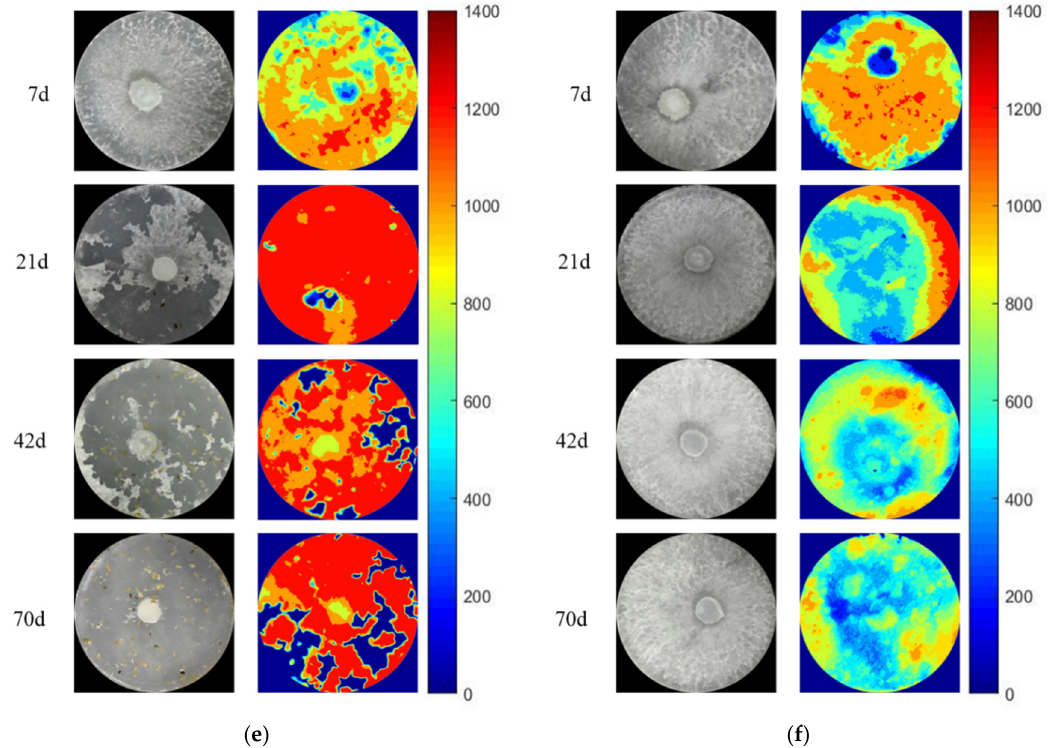
Figure 5. Spatial distribution of enzyme activities of grazing area (External litter: P. massoniana ): ( a , b ) acid phosphatase, ( c , d ) β - N -acetylhexosaminidase, ( e , f ) β -1,4-glucosidase. ( a , c , e ) under isopods grazing; ( b , d , f ) without isopods grazing. Side color maps are proportional to the enzyme activities (pmol·cm − 2 ·h − 1 ). Table 2. Enzyme activity measured by zymography at 7 days, 21 days, 42 days and 70 days in the grazing area (pmol · cm − 2 · h − 1 ).